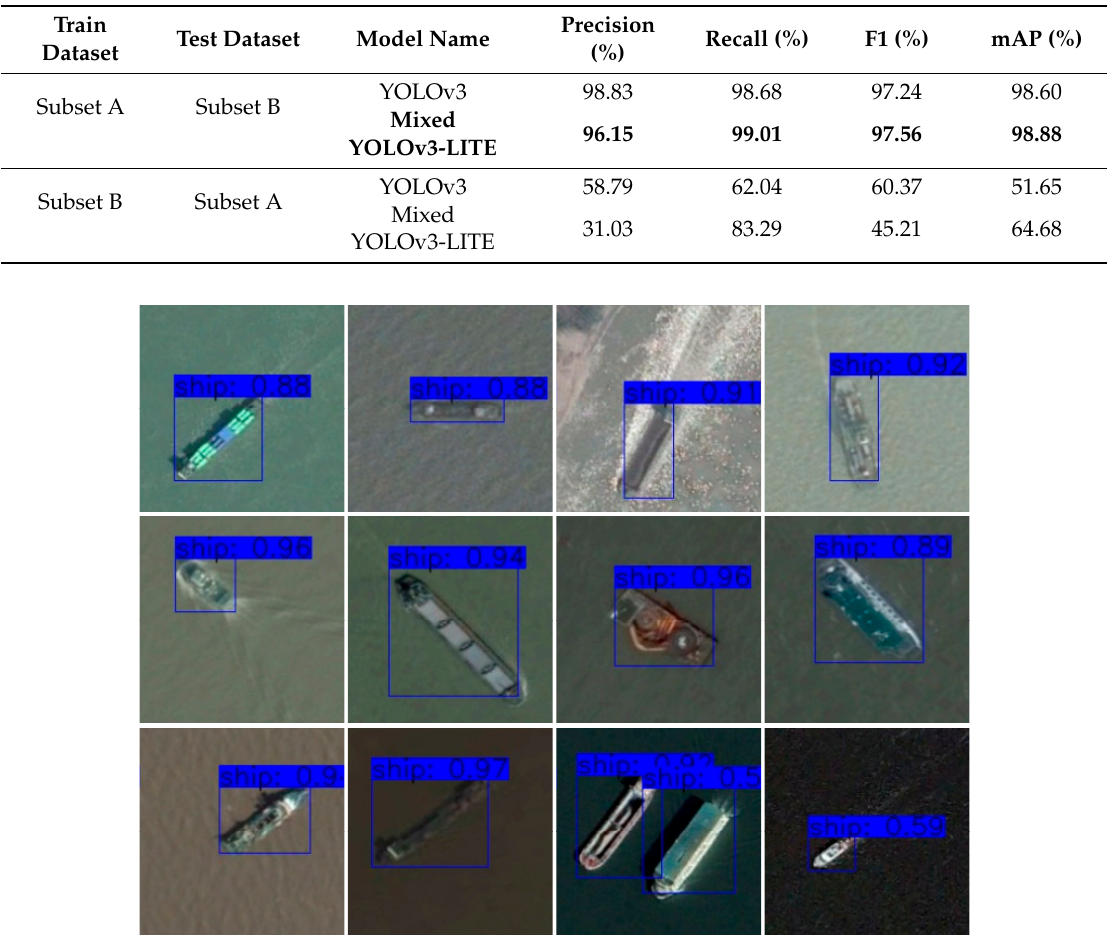
Table 9. Evaluation results for YOLOv3 and Mixed YOLOv3-LITE for ShipData.